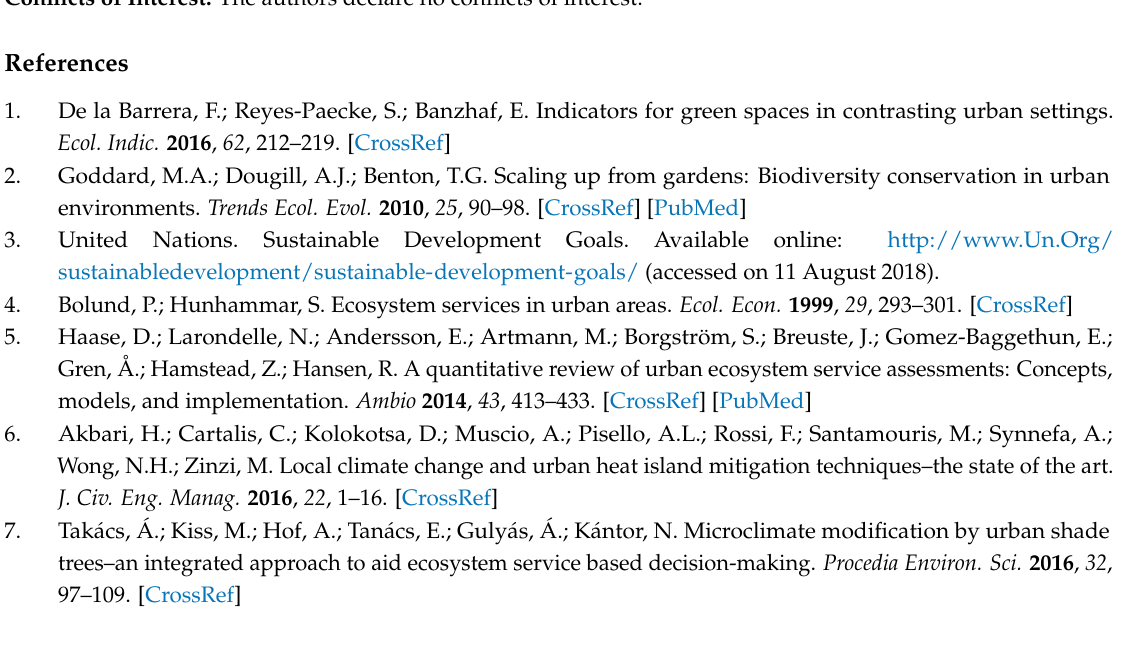
s1, Table S1: Summary statistics of populations in 262 cities based on provinces, Table S2: Correlations between the five landscape metrics, Figure S1: Spatial distribution of Mean Euclidian nearest neighbor distance (ENN_MN, m) value, Figure S2: Spatial distribution of Largest Patch Index (LPI, %) value, Figure S3: Spatial distribution of Patch density (PD, count/km2) value, Figure S4: Spatial distribution of Mean patch shape index (SHAPE_MN) value, Supplementary file 1: Cities investigated in this study, and Supplementary file 2: Confusion matrix of land cover classification for each